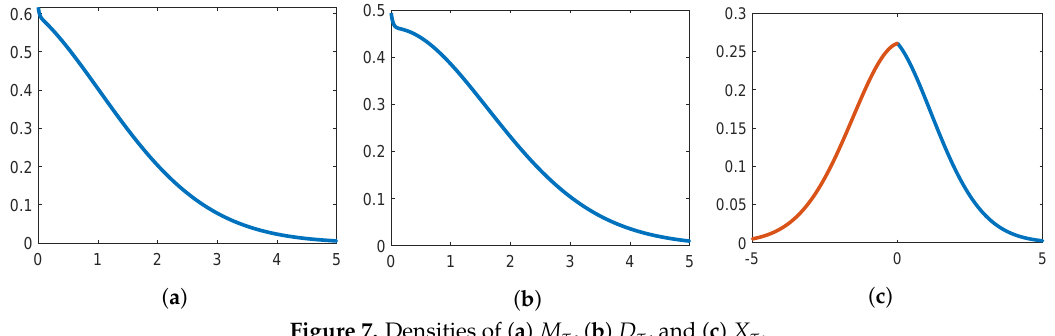
Figure 7. Densities of ( a ) M τ , ( b ) D τ , and ( c ) X τ